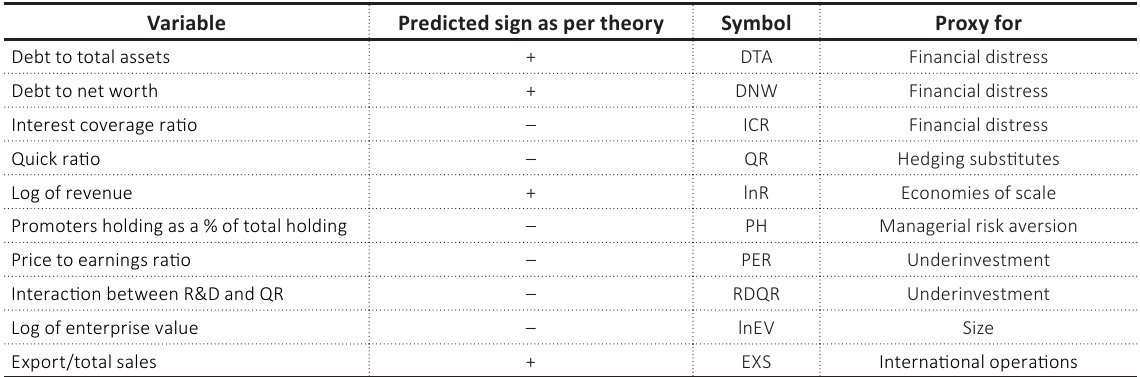
Table 1. Variables for the